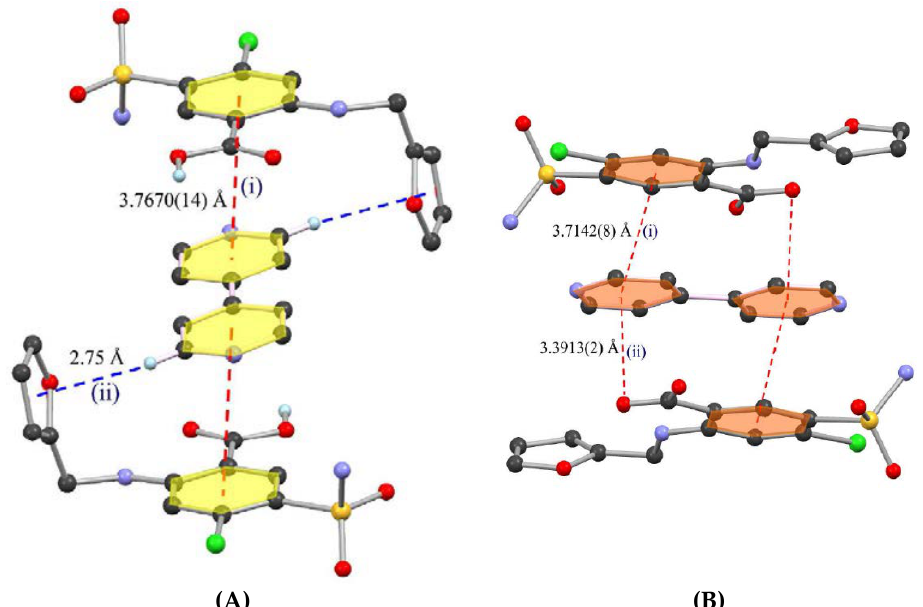
Figure 20. Sandwich motifs in colored furosemide-4,4 (cid:48) -bipyridine (2:1) cocrystal polymorphs ( A ) form I and ( B ) form IIformed via Π ... Π interactions and C-H... Π interactions [Reprinted from [257] with permission. Copyright 2015 American Chemical Society].